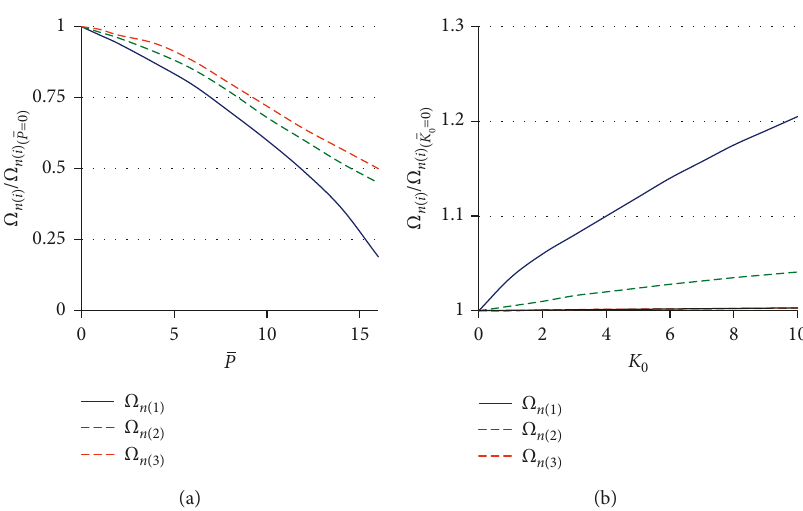
Figure 3: Variation of frequency modes with axial force and foundation stiffness.